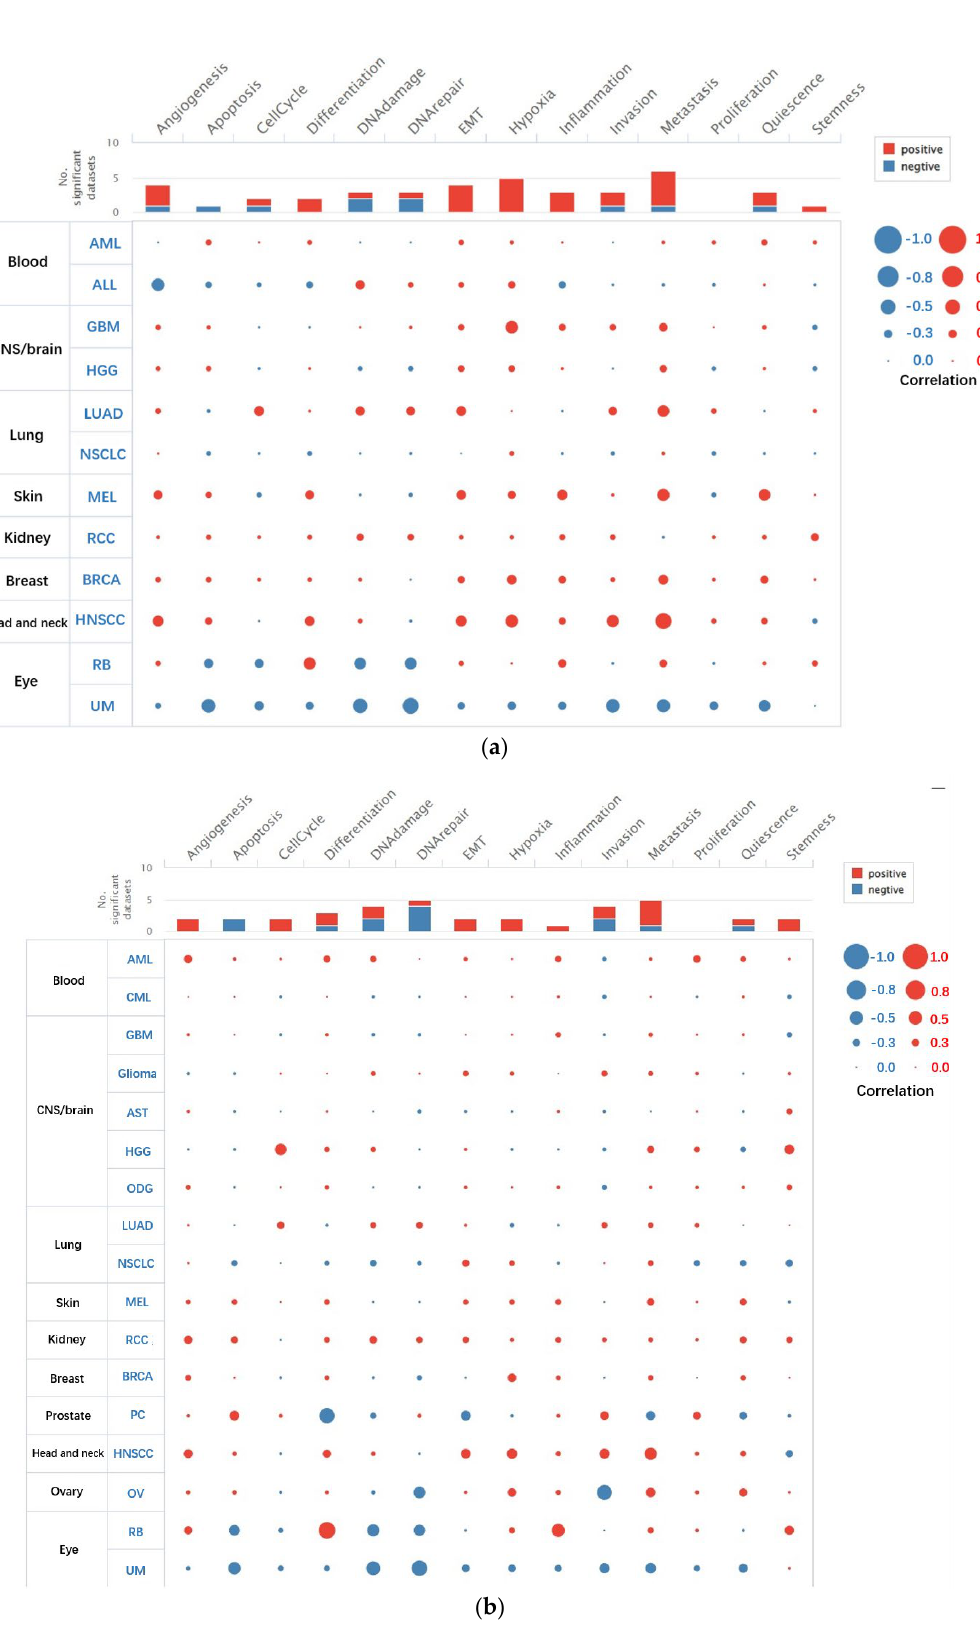
( b ) Figure 2. Comparison of mRNA expression levels of CAV1 and CAV2 between HNSC and normal tissues. Box plot chart (( a ), mean ± SD: Normal: 11.11 ± 1.02, Tumor: 12.51 ± 1.53; ( b ), mean ± SD: